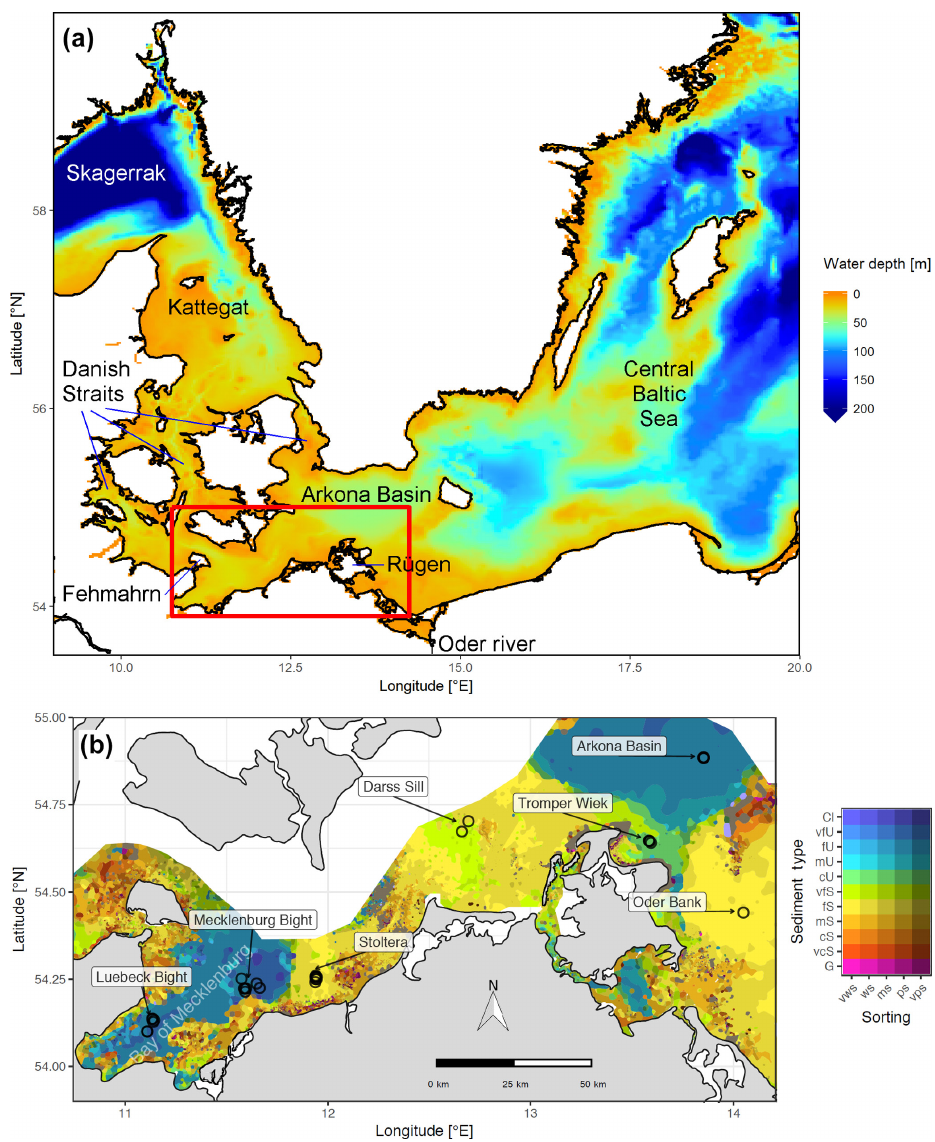
Figure 1. (a) Bathymetry of the western Baltic Sea and location of our area of interest. (b) The investigation area of the SECOS project. The map shows granulometry, redrawn from Tauber (2012) and Lipka (2018), and the seven stations considered in this model study. Sediment type: Cl – clay, vfU – very fine silt, fU – fine silt, mU – medium silt, cU – coarse silt, vfS – very fine sand, fS – fine sand, mS – medium sand, cS – coarse sand, vcS – very coarse sand, G – gravel. Sorting: vws – very well sorted, ws – well sorted, ms – moderately sorted, ps – poorly sorted, vps – very poorly